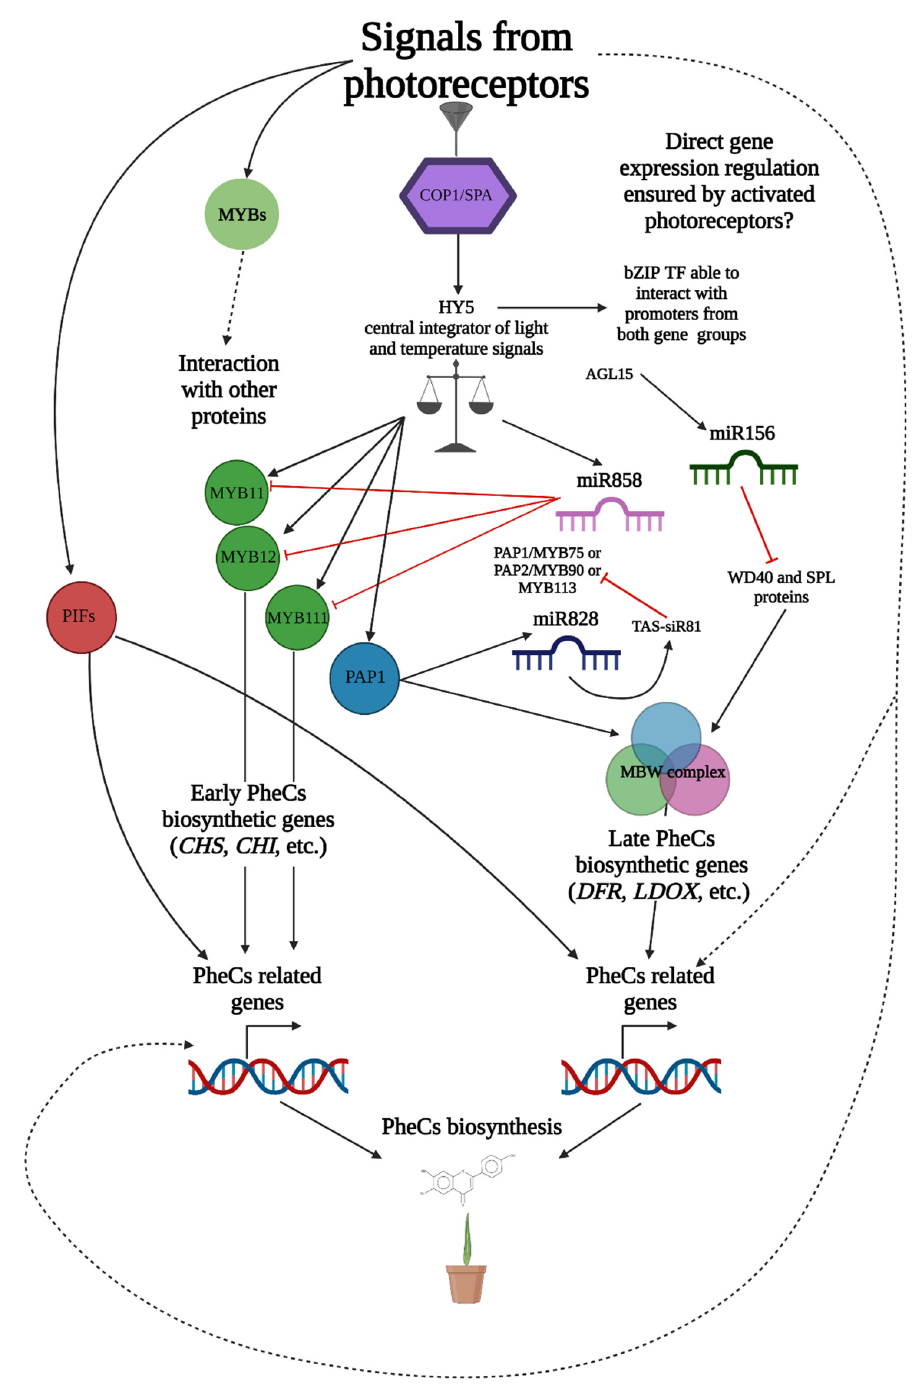
Figure 2. Simplified schematic representation of genes related to PheC biosynthesis and their regulation. Solid black arrows indicate known interactions, signaling, and regulatory mechanisms involved in PheC synthesis. Dashed black arrows mark other presumed regulatory pathways which are not yet confirmed. Red lines mark known downregulation or inhibitory interactions. TF (transcription factor), COP1/SPA complex (CONSTITUTIVELY PHOTOMORPHOGENIC 1, SUPPRESSOR OF PHYA-105); HY5 (ELONGATED HYPOCOTYL 5); PIFs (PHYTOCHROME INTERACTING FACTORS); miRNA (micro ribonucleic acid); MBW complex consisting of three proteins— MYB75 (PAP1), bHLH (TT8), and WD40 (TTG1); CHS (chalcone synthase; EC 2.3.1.74); CHI (chalcone isomerase, EC 5.5.1.6); DFR (dihydroflavonol 4-reductase; EC 1.1.1.219); and LDOX (leucocyanidin oxygenase; EC 1.14.11.19).